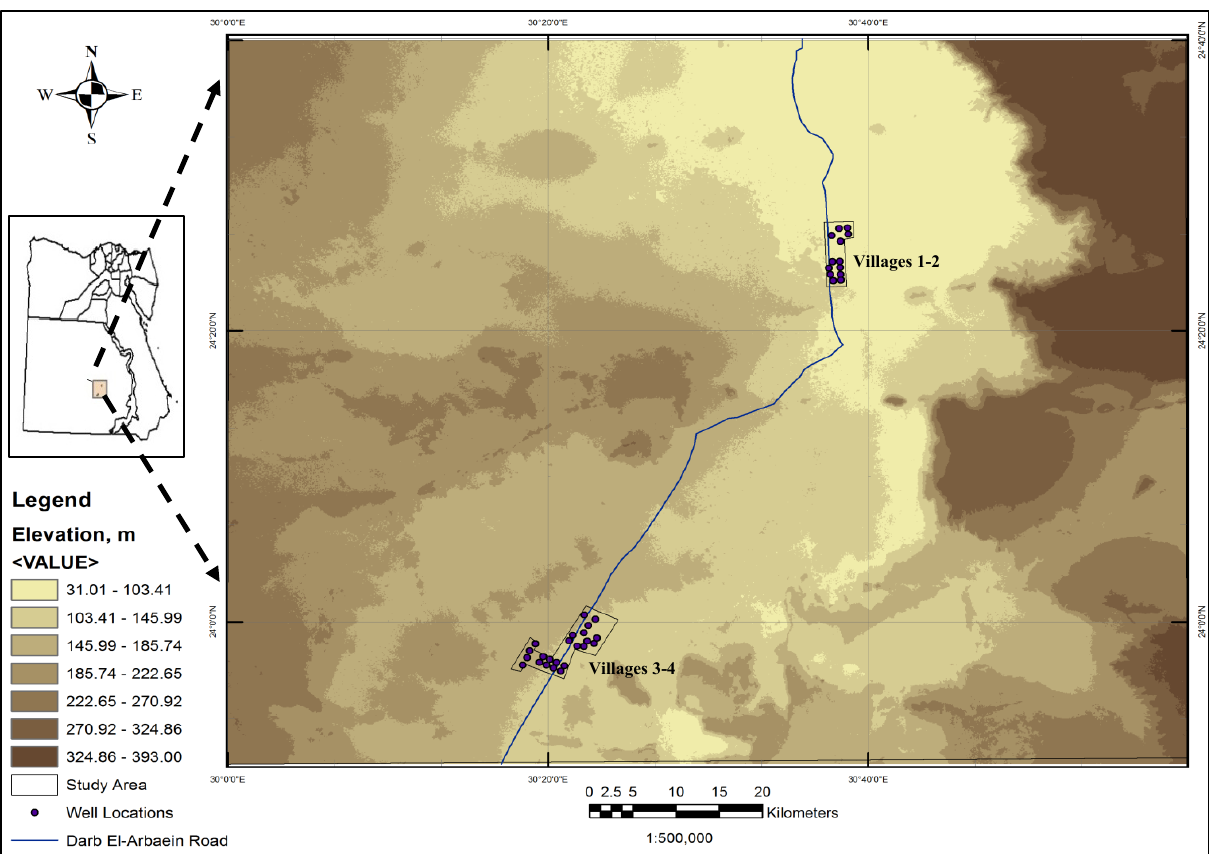
Figure 1. Location map of the study area in relation to